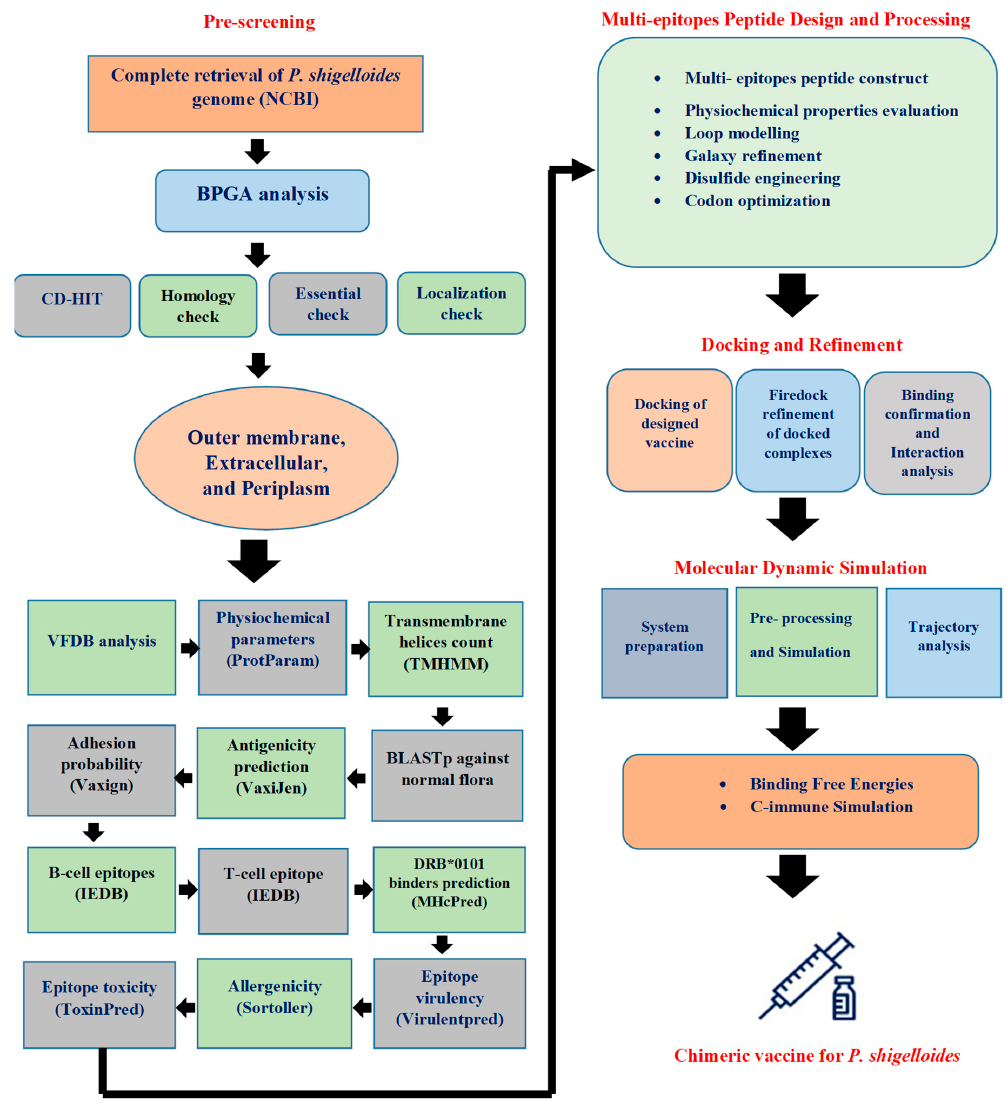
Figure 1. Methodology flow for designing a novel multi-antigenic epitopes vaccine against P. shigelloides.